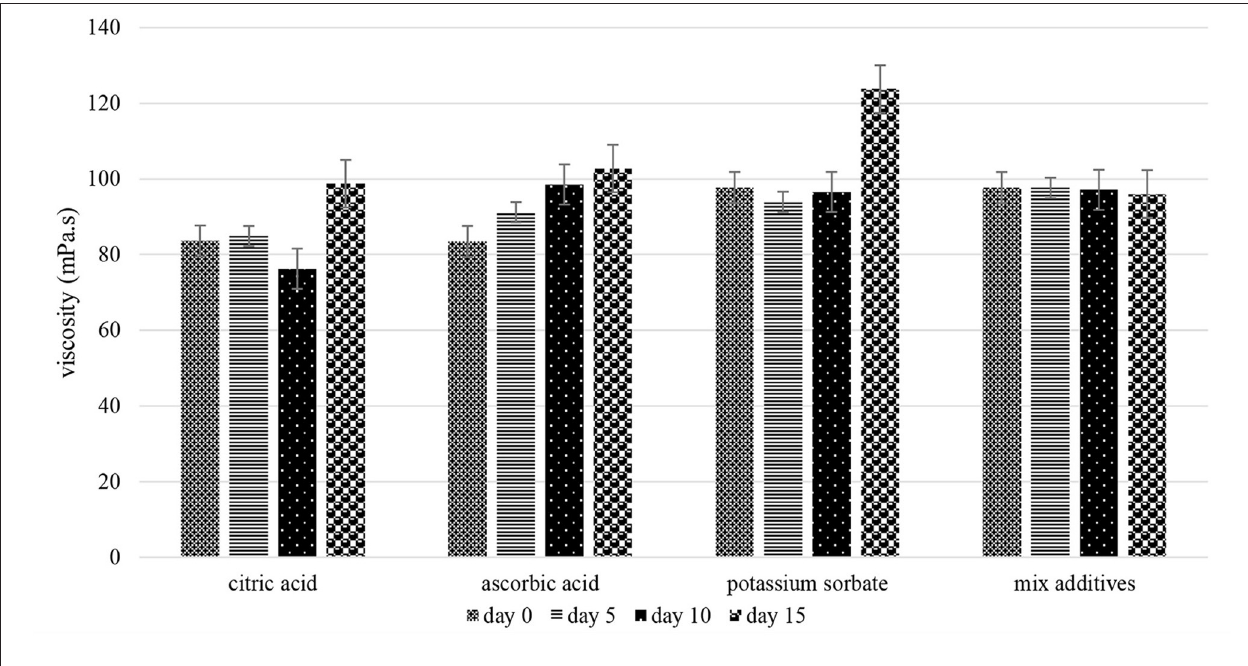
FIGURE 3 | AVG coating viscosity (mPa.s).